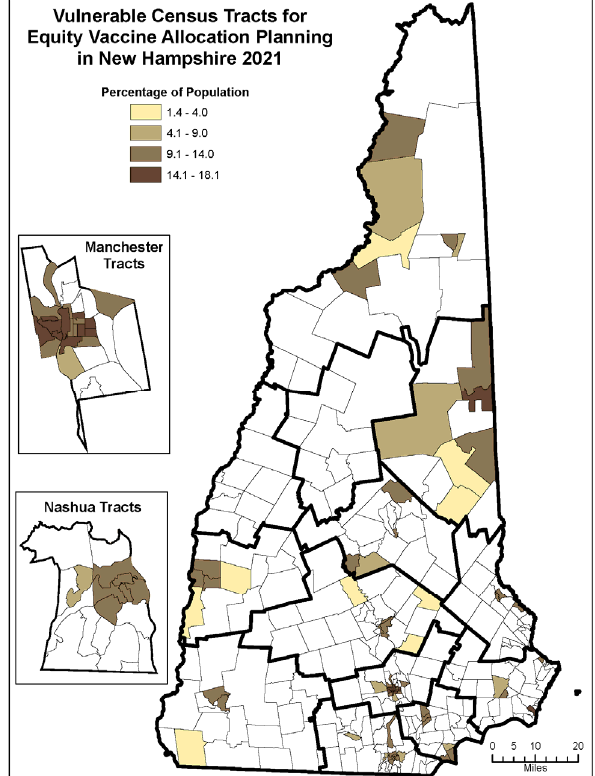
Figure 3. Vulnerable Census Tracts for Equity Vaccine Allocation Planning in NH. The VASB utilized the COVID-19 Community Vulnerability Index (CCVI) and Census data for population estimates to identify the communities at highest risk for disproportionate impact of COVID-19. Manchester and Nashua, the most populous cities in NH, are highlighted on the left. Only the top quartile of most vulnerable census tracts in NH are shown in the figure above.